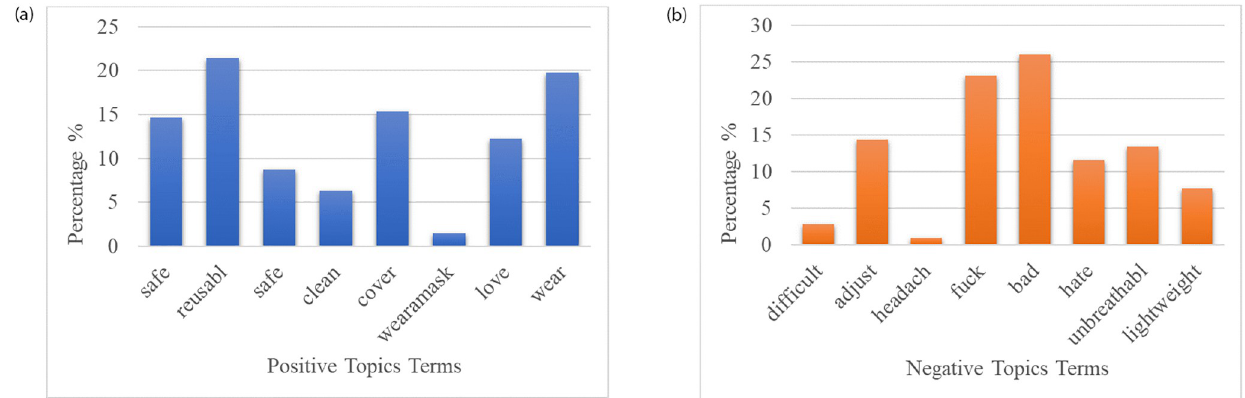
Fig 11. Positive and negative tweets topics term percentage in data, (a) Positive Topics Terms, (b) Negative Topics Terms.